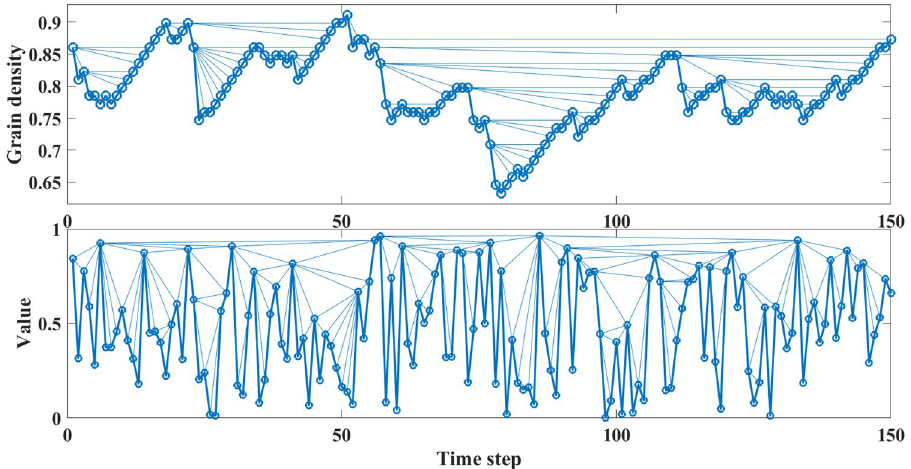
Figure 11. A HVG plot for a sample of 150 data points generated by the Manna sand-pile model (top panel), and a HVG of the same size TS generated by a uniform random algorithm (bottom